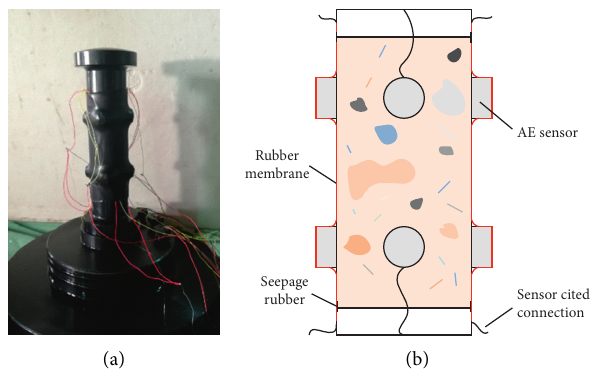
Figure 2: Sealed sample (a) and sensor assembly diagram